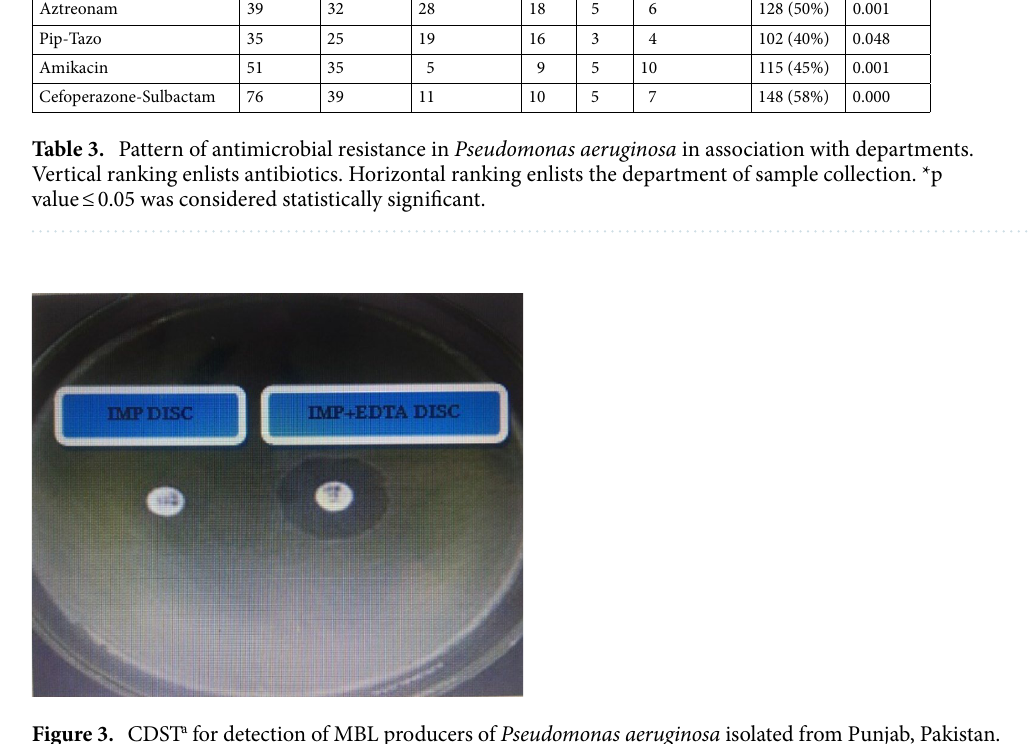
Figure 3. CDST a for detection of MBL producers of Pseudomonas aeruginosa isolated from Punjab, Pakistan. This test shows using a disc of IMP b alone and IMP/EDTA disc as per methodology of Wadekar et al . 24 . A wider zone of inhibition is measured with IMP/EDTA disc as compared to IMP disc alone. This identifies metallo β-lactamase producers. a CDST Combined disc synergy disc; b